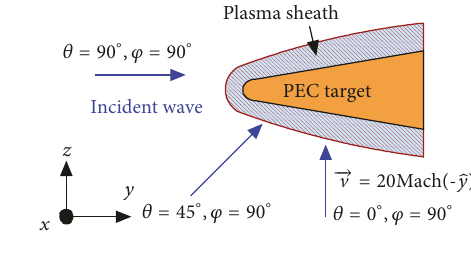
Figure 11: Cone model.